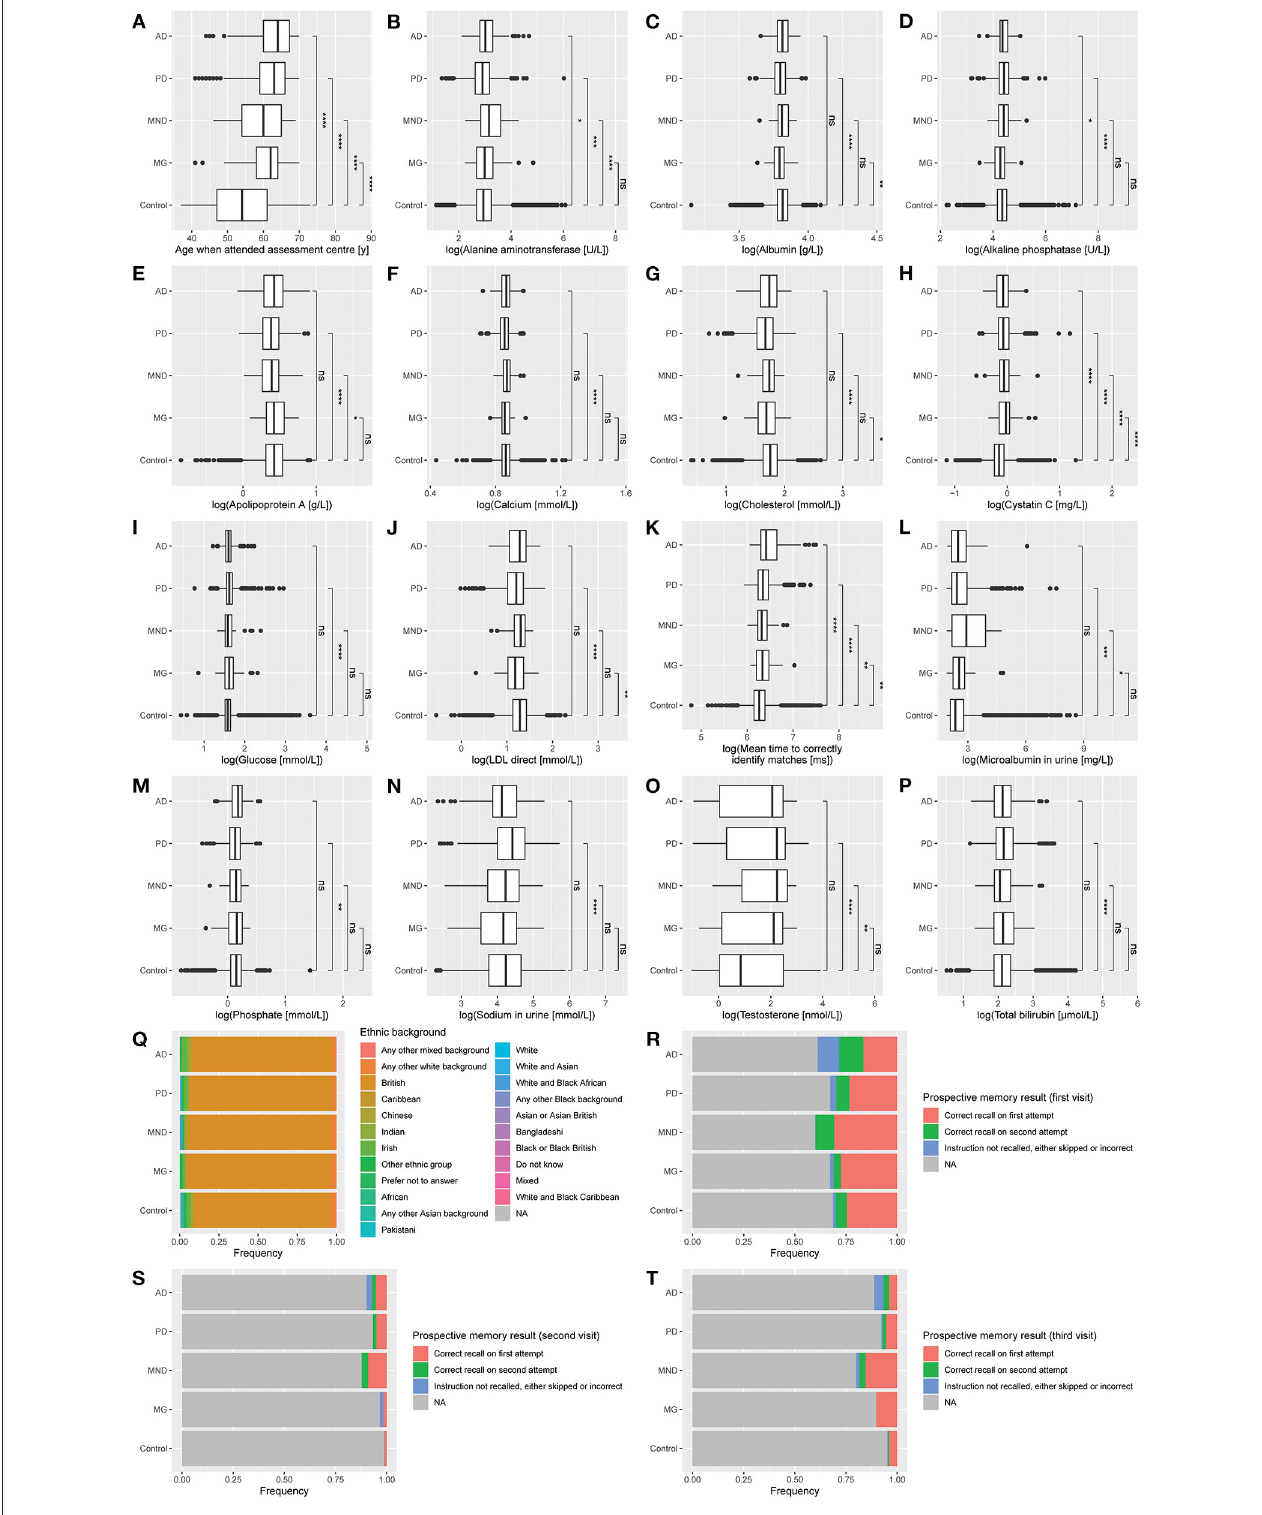
FIGURE 2 | Distribution of clinical measures by diagnosis. (A) Age when attended assessment center. (B) Alanine aminotransferase. (C) Albumin. (D) Alkaline phosphatase. (E) Apolipoprotein A. (F) Calcium. (G) Cholesterol. (H) Cystatin C. (I) Glucose. (J) LDL direct. (K) Mean time to correctly identify matches. (L) Microalbumin in urine. (M) Phosphate. (N) Sodium in urine. (O) Testosterone. (P) Total bilirubin. (Q) Ethnic background. (R) Prospective memory result (first visit).